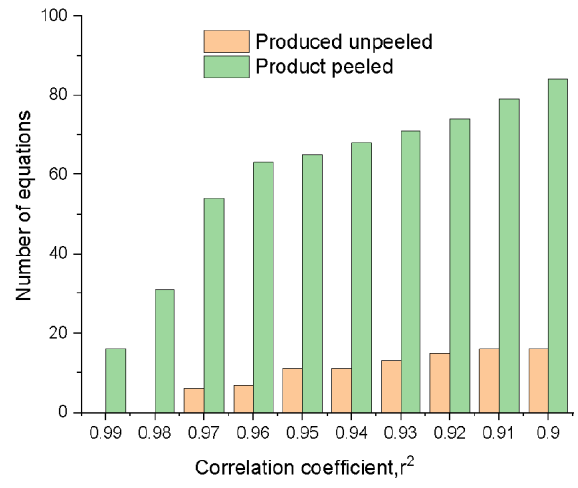
Figure 16. The correlation coefficient is used to represent the number of common equations. 9.